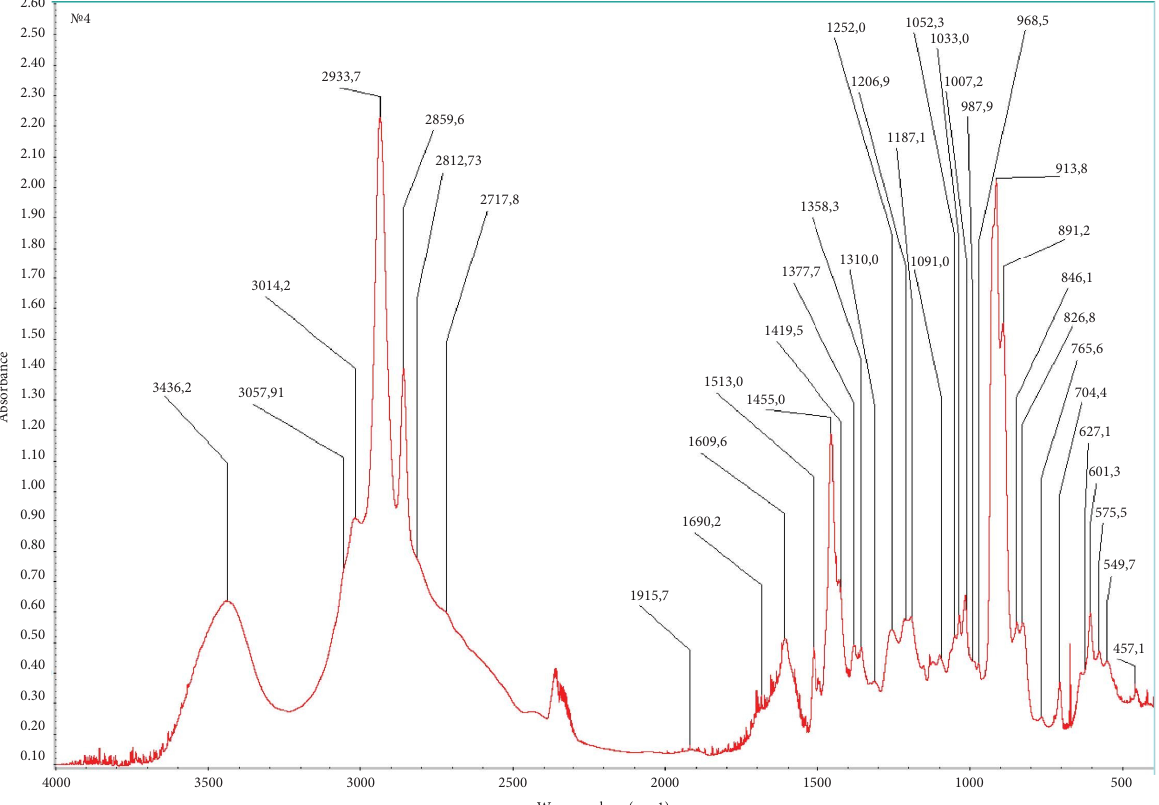
Figure 8: Sample no. 4: resin with rhenium ions and other impurities. Table 6: Results of rhenium desorption. Desorption